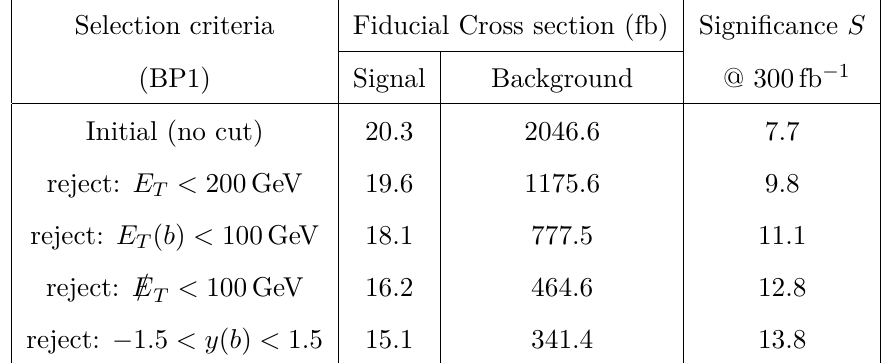
H 0 /A 1 A 1 ) and the SM back- 1 1